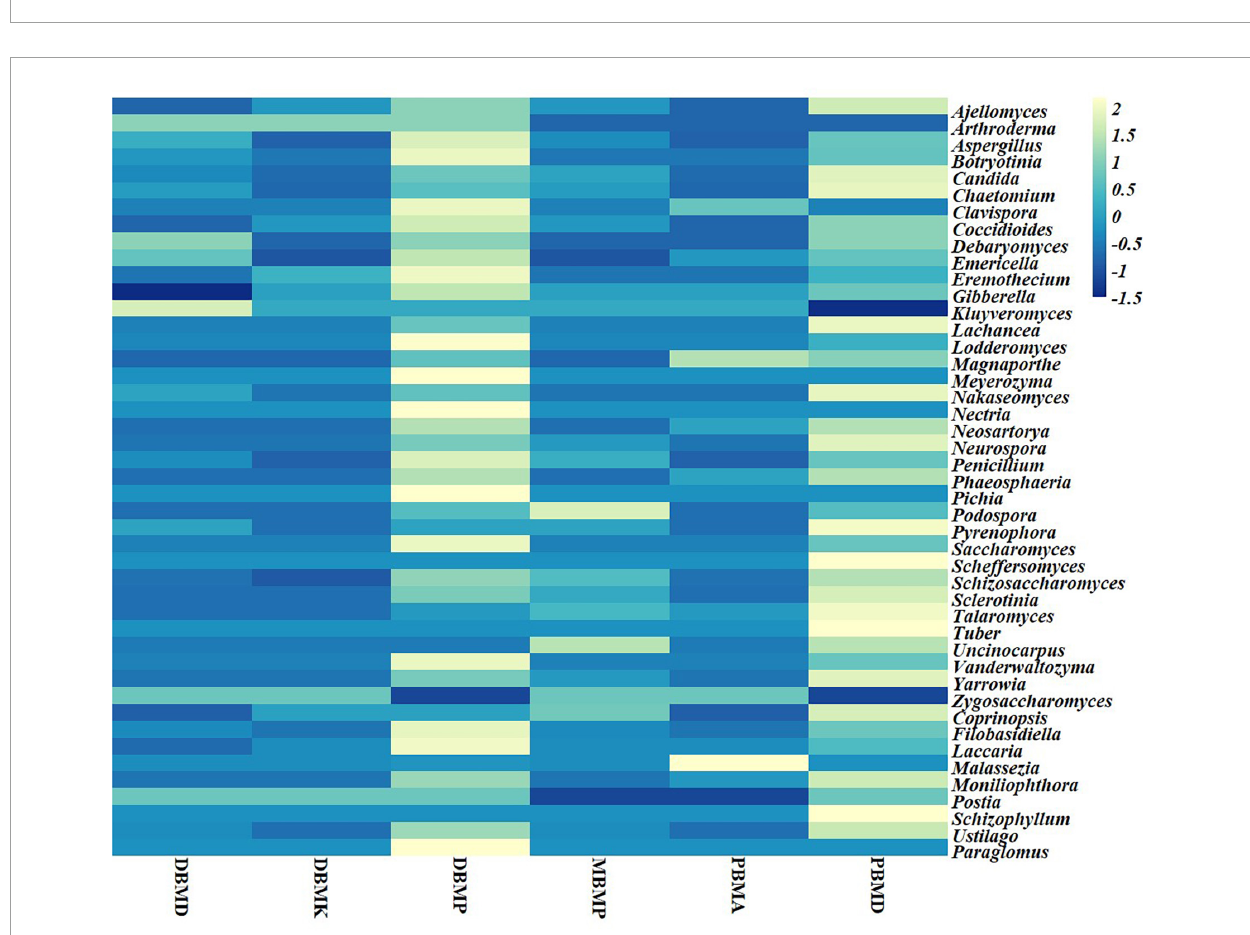
FIGURE5 Heat map representation of major fungal genera communities in moiya pangsung, mileye amileye, moiya koshak, and midukeye .